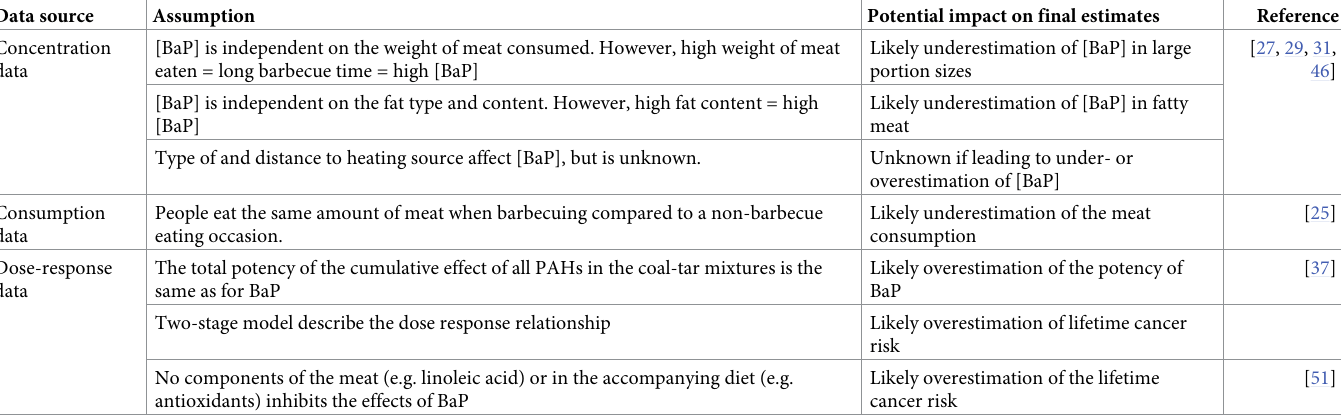
Table 5. List of assumptions and potential impact on the